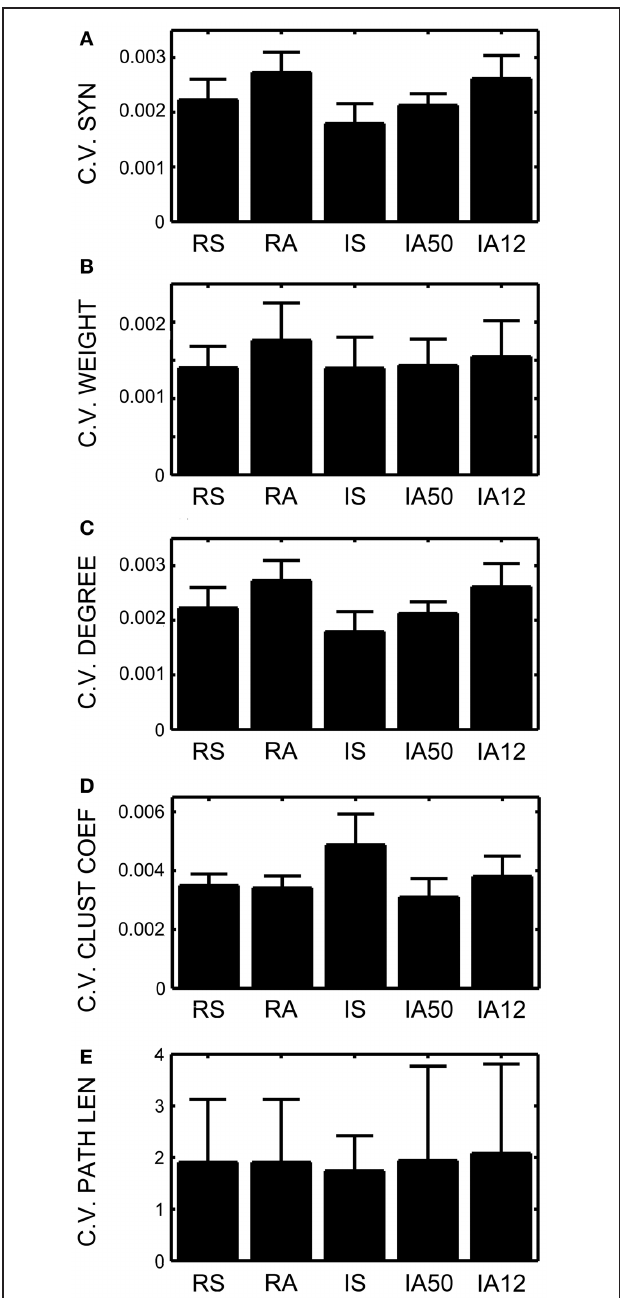
FIGURE 4 | Coefficients of variation across time. Coefficients of variation (the standard deviation across time divided by the mean) for (A) Total number of excitatory synapses, (B) Average synaptic weight, (C) Average total neuronal degrees, (D) Average weighted and directed clustering coefficient, and (E) The average weighted and directed path length. Error bars represent SD’s across the 10 simulations for each input regime.